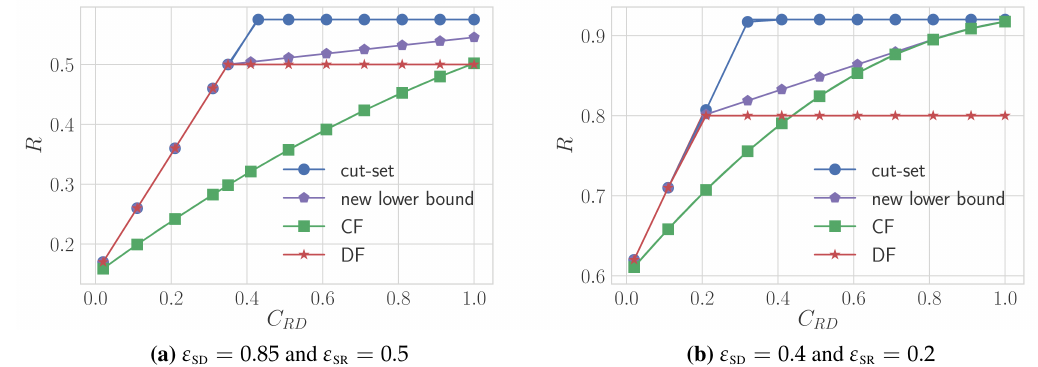
Figure 4. Comparison between the achievable rate provided by our strategy and the existing upper and lower bounds. We use “CF" and “DF" as abbreviations for “compress-and-forward” and “decode-and-forward”, respectively.